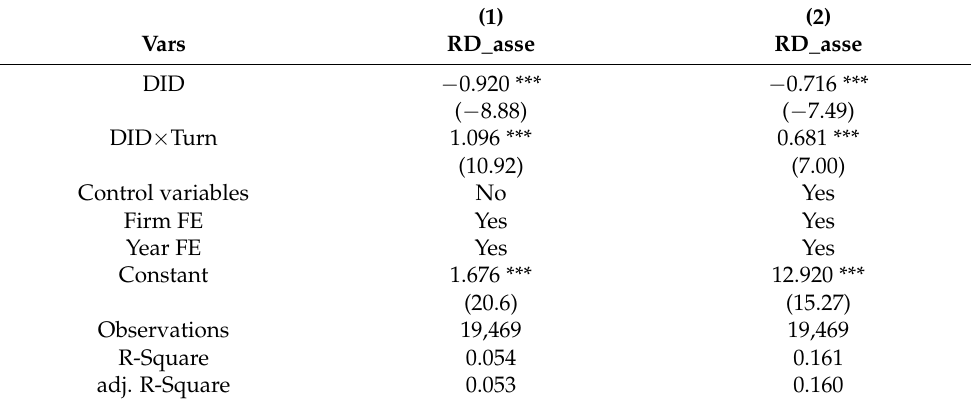
Table 10. Test of the moderating effect of firm operating